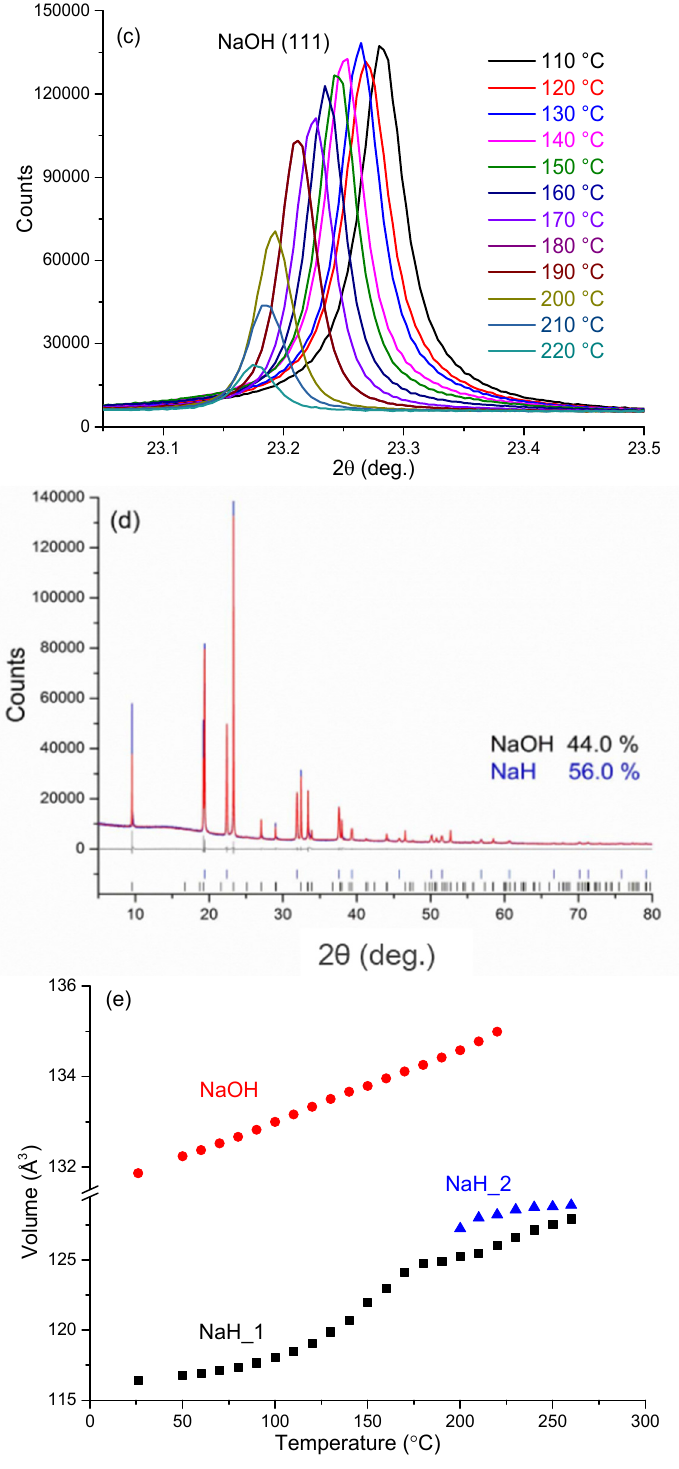
Figure 7. In-situ synchrotron PXD patterns for sample 5 heated from room temperature to 260 °C with a constant heating rate of 10 °C min –1 in a closed quartz capillary under Ar atmosphere ( λ = 0.9533 Å) showing: ( a ) the region from 7° ≤ 2 θ≤ 40°; ( b ) the change in the NaH (200) reflections from 110 to 220 °C; ( c ) the change in the NaOH (111) reflections from 110 to 220 °C; ( d ) the refinement profile at 100 °C; and ( e ) cell volume against temperature for NaH (“NaH_1”), “Na-O-H” (“NaH_2”) and NaOH, respectively, from room temperature to 260